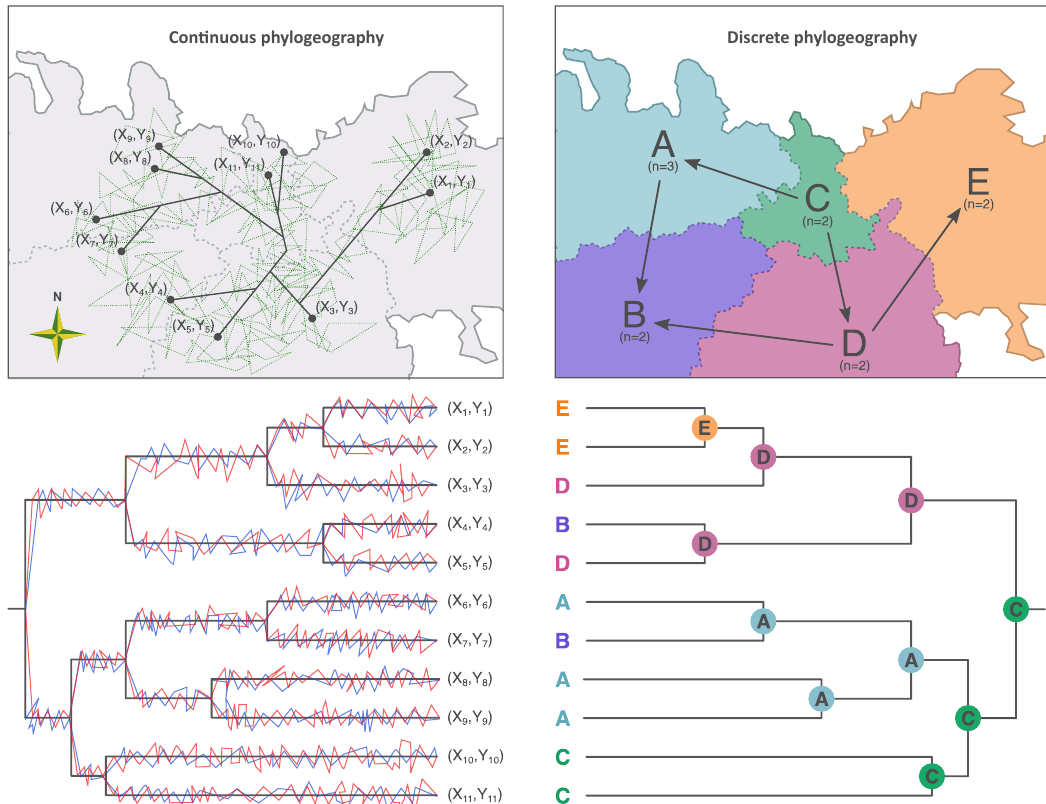
Figure 2. Comparison between continuous and discrete phylogeographic inferences, two methods that have been frequently used to reconstruct the spread of RABV lineages. Both methods can be seen as character mapping approaches: ancestral reconstruction of the longitude X (in blue) and latitude Y (in red) in the case of the continuous phylogeographic